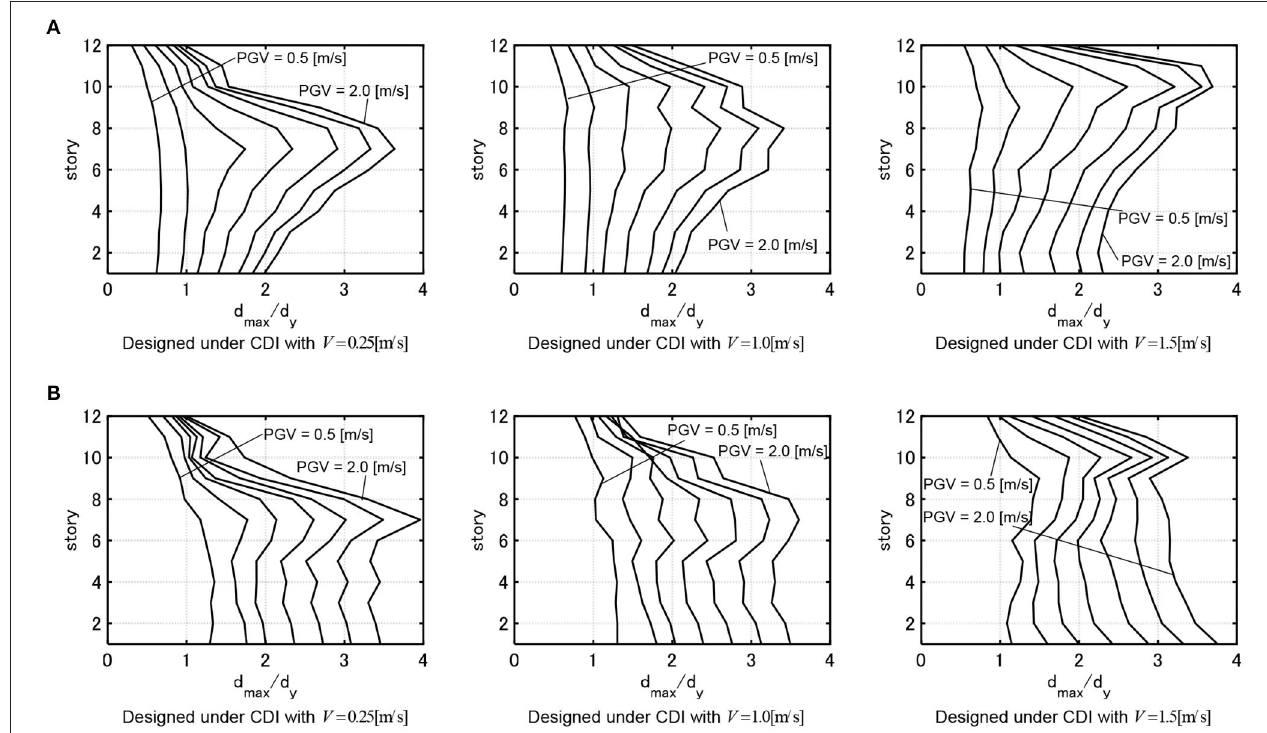
FIGURE 15 | Maximum interstory drifts for amplified recorded ground motions, (A) Rinaldi Station FN (Northridge 1994), (B) Kobe Univ NS (Hyogoken-Nanbu